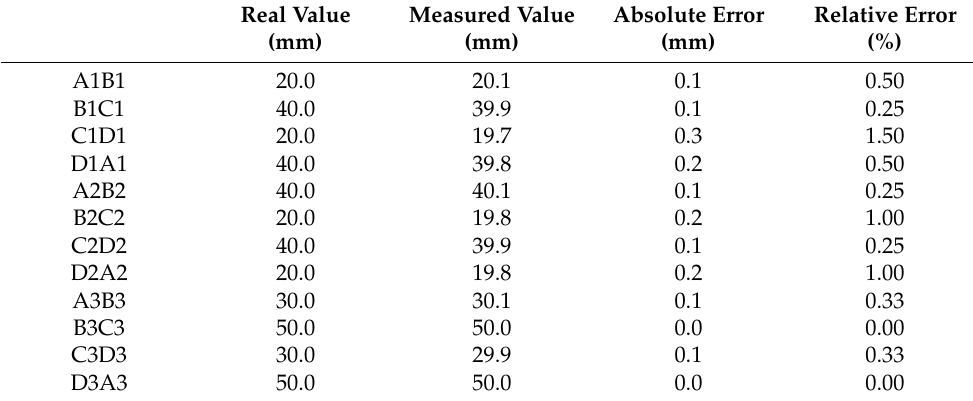
Table 1. Comparison of measured data with real values.